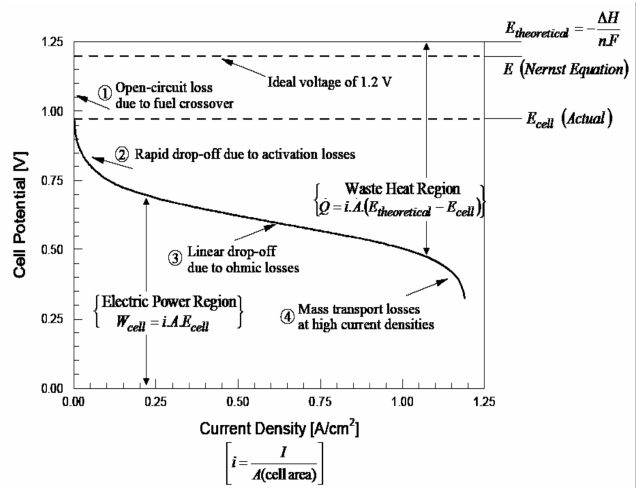
Figure 4. Typical polarization curve of a PEM-FC and predominant loss mechanisms in various current density